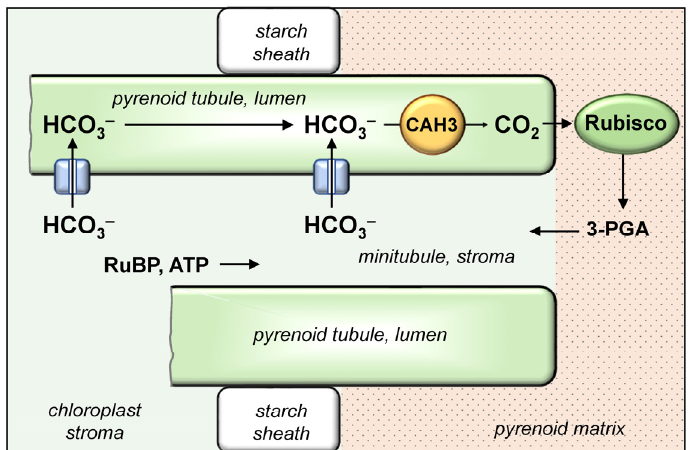
Figure 7. Pyrenoid tubules with minitubules: schematic representation of the cross-sectional plane of C. reinhardtii cells at the entrance of pyrenoid tubules into the pyrenoid matrix.